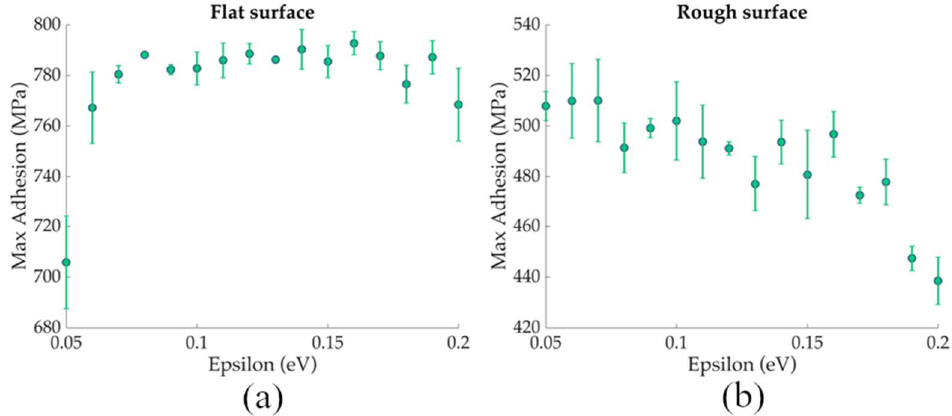
Figure 2. Ice adhesion strength on flat ( a ) and rough ( b ) surfaces with different epsilon values. The error bars show the standard deviation of three independent simulations.